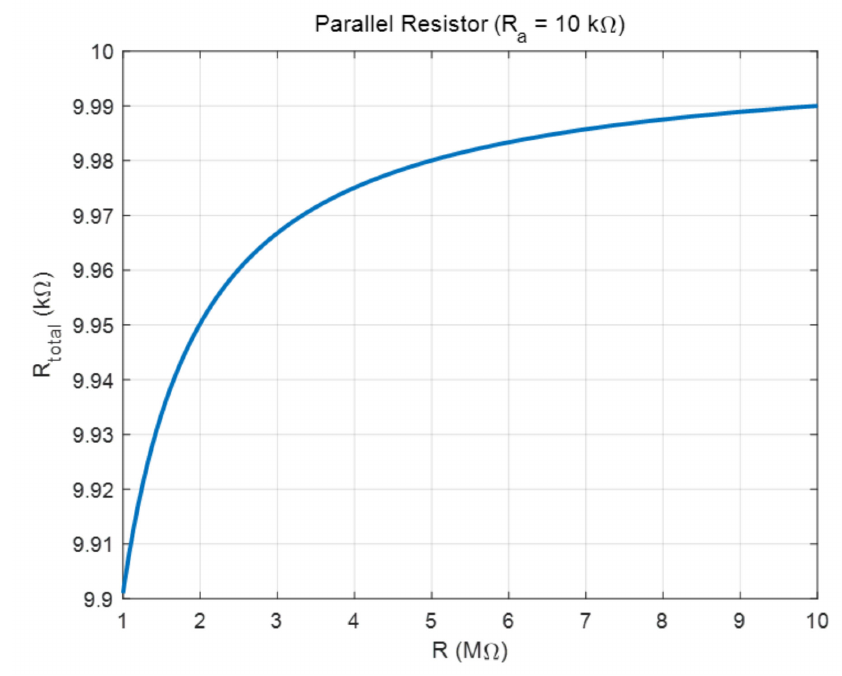
Figure 7. Change in resistance of the two plate electrodes and change in total